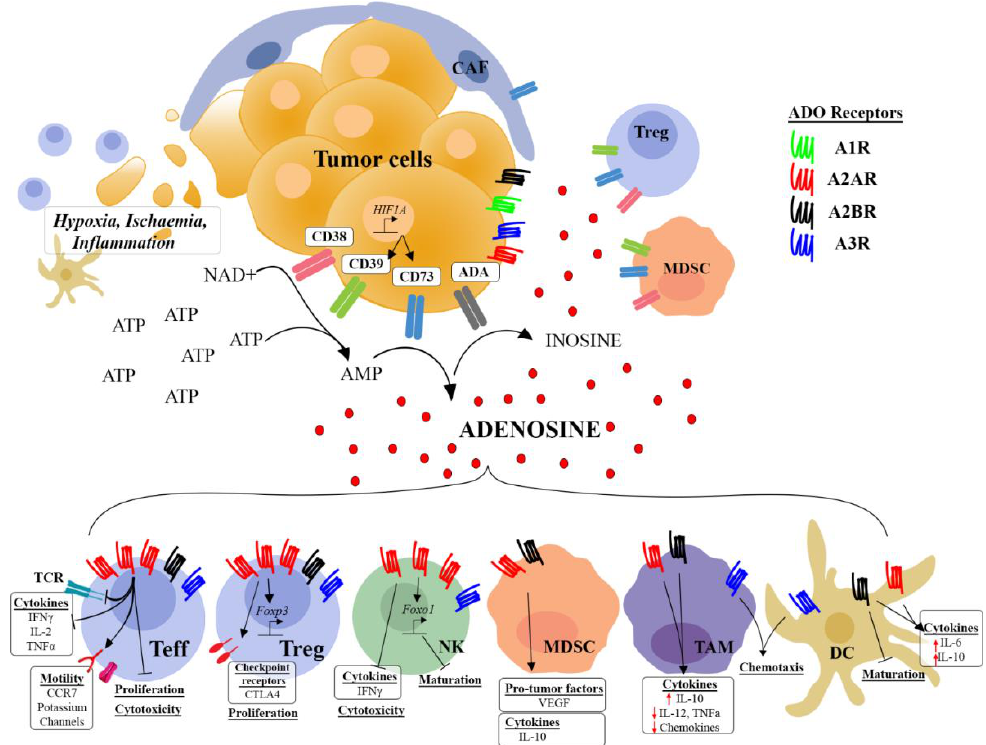
Figure 1. Generation of adenosine in the tumor microenvironment leads to the suppression of multiple immune subsets. Arrows indicate increased expression or activation. T bars indicate inhibition or reduced activity.